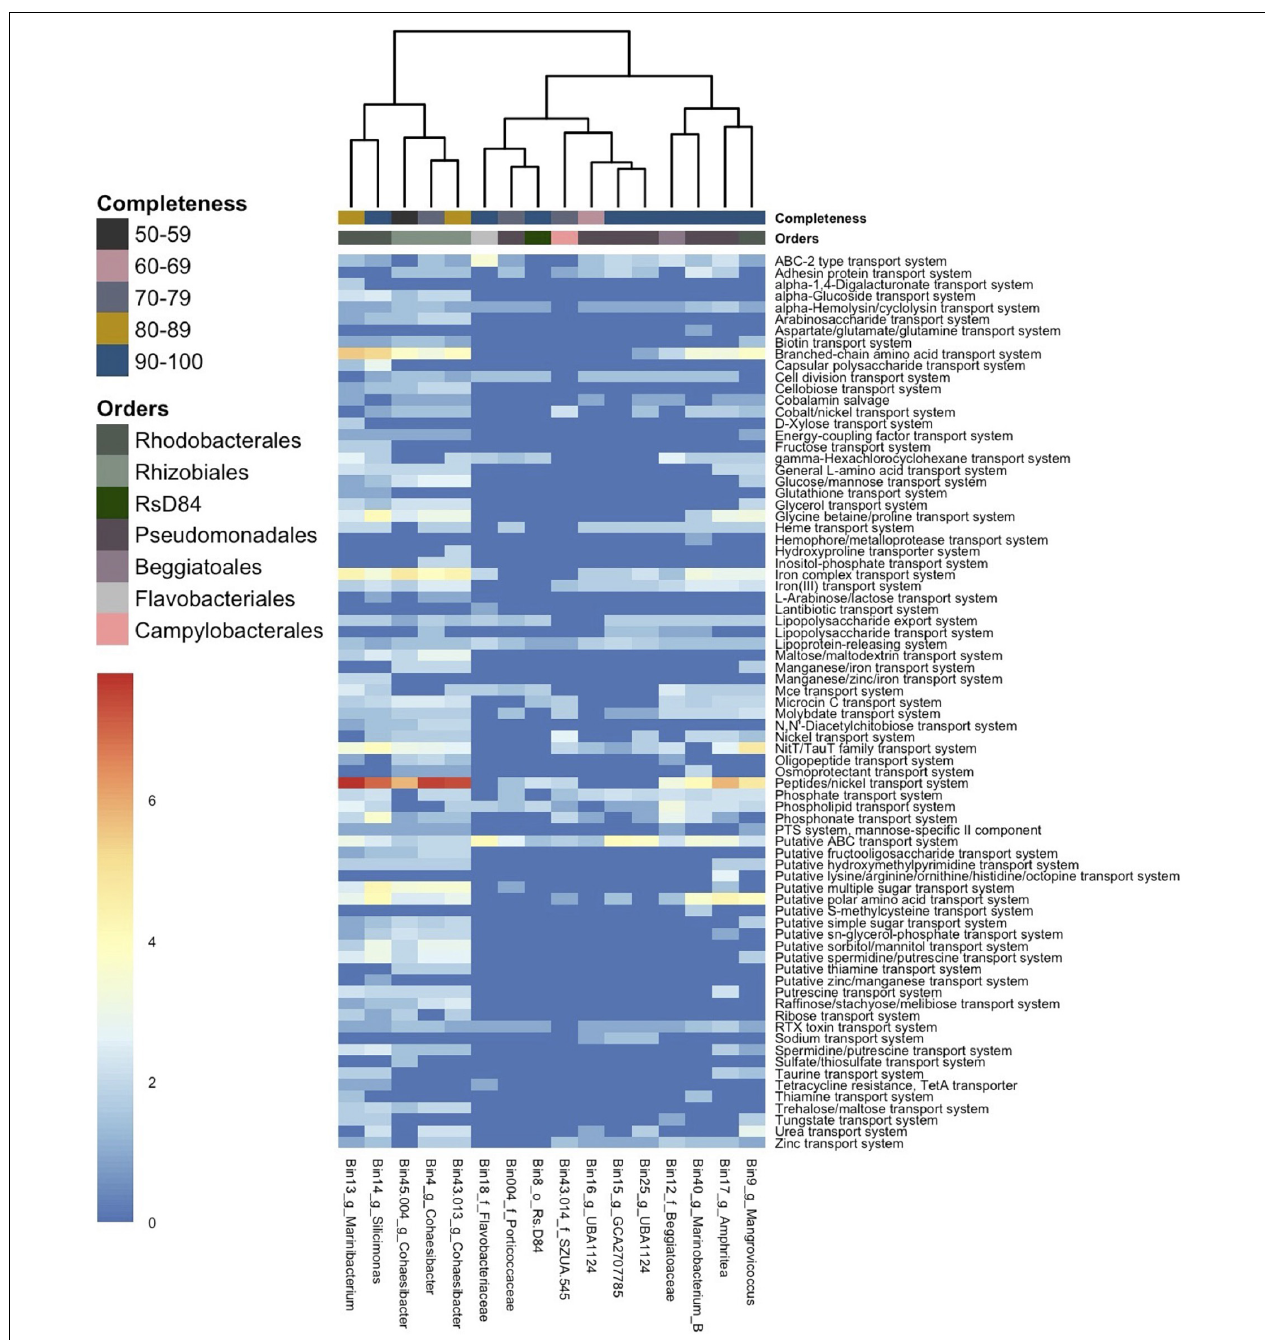
FIGURE 5 | Gene counts of transporter genes across 16 metagenome-assembled genomes (MAGs). The heatmap shows the number of gene counts (square root transformed) found in each MAG from Distilled and Refined Annotation of Metabolism (DRAM) analysis. The MAGs ( x -axis) are labeled by bin number and the lowest taxonomic assignment designated. The x -axis is hierarchically clustered by Euclidean distance among genes present in each MAG (bottom) and colored (as in Figure 3 ) by the respective bacteria order (top) and by genome completeness of the MAGs (top) .